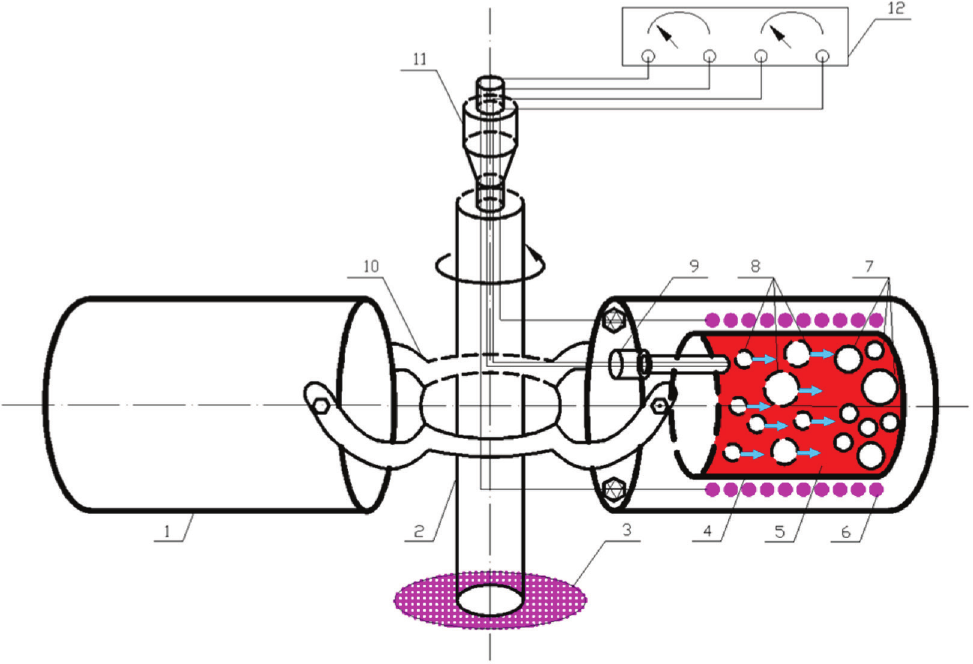
Fig. 2: Schematic diagram of centrifugal concentration apparatus. 1. Counterweight; 2. Centrifugal axis; 3. Base; 4. alumina crucible; 5. Gangue melt; 6. Resistance coil; 7. V-containing spinel crystals after centrifugal concentration; 8. V-containing spinel crystals before centrifugal concentration; 9. Thermocouple; 10. Horizontal rotor; 11. Conductive slipping; 12. Temperature